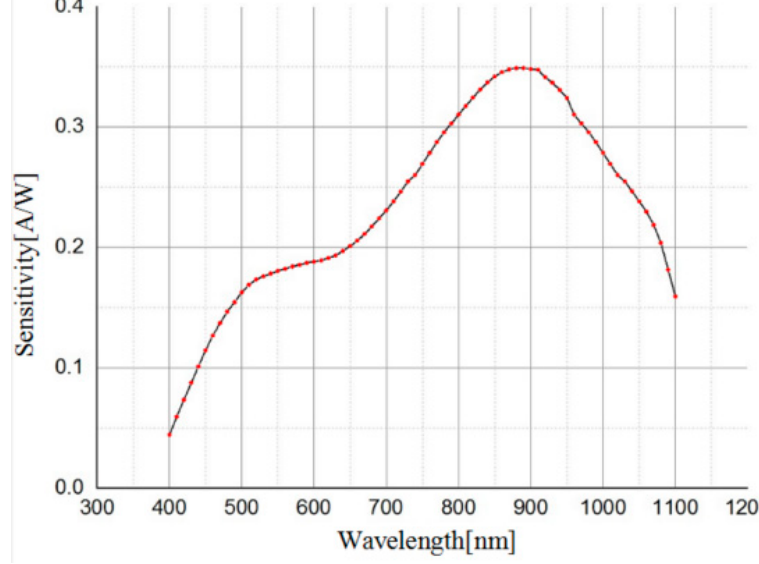
Figure 16. Measured spectral response of the PD.